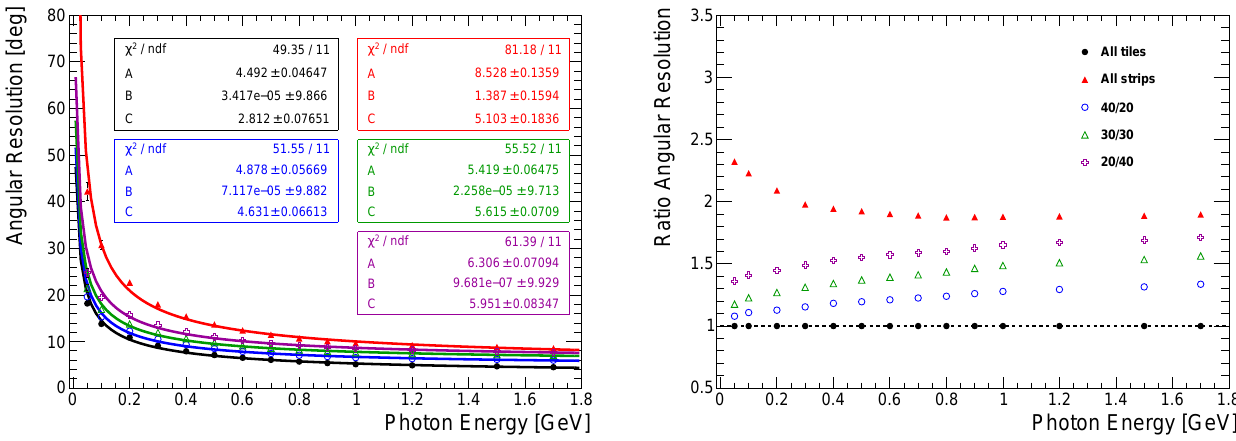
Figure 76. Angular resolution and ratio for different ECAL detector granularity